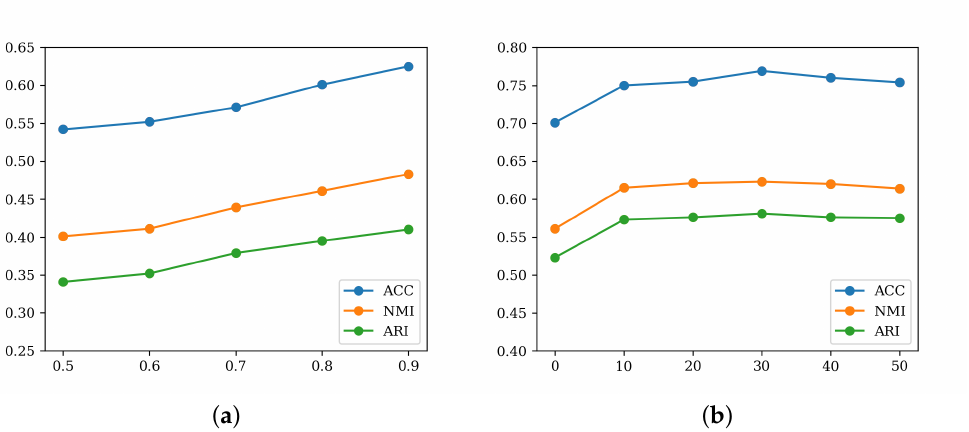
Figure 4. Clustering performance under different thresholds and z . ( a ) Impact of threshold. ( b ) The dimensional impact of z .